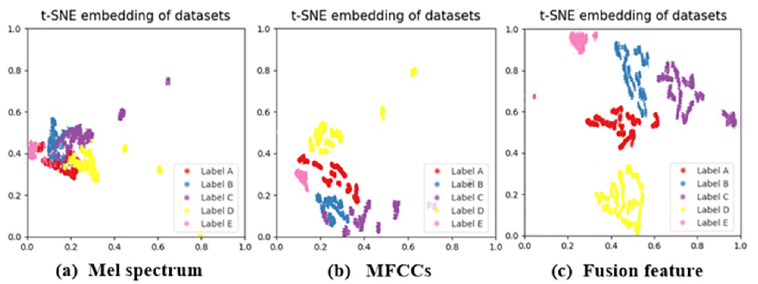
Fig 4. t-SNE visualization result of the Mel spectrum, MFCCs feature and fusion feature. (a) Mel spectrum; (b) MFCCs; (c) fusion